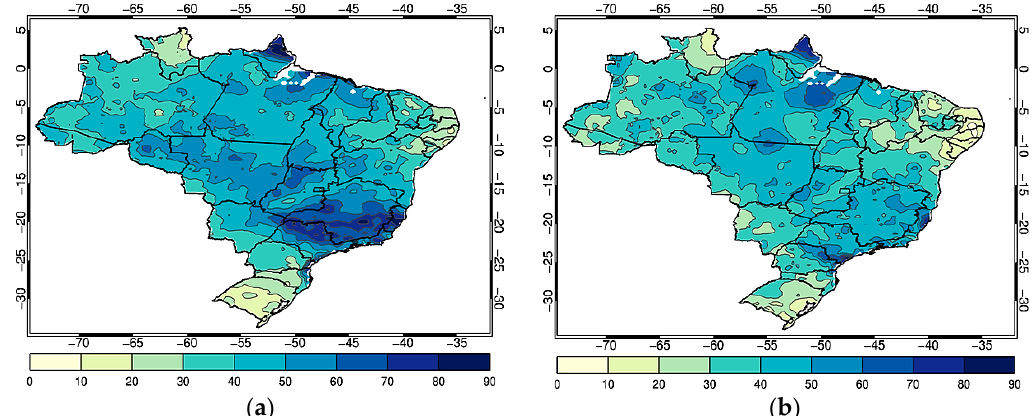
Figure 6. Mean standard deviation of accumulated precipitation (mm/event) in SACZ episodes ( a ) at AAO+ and ( b ) at AAO – . AAO+ and ( b ) at AAO −